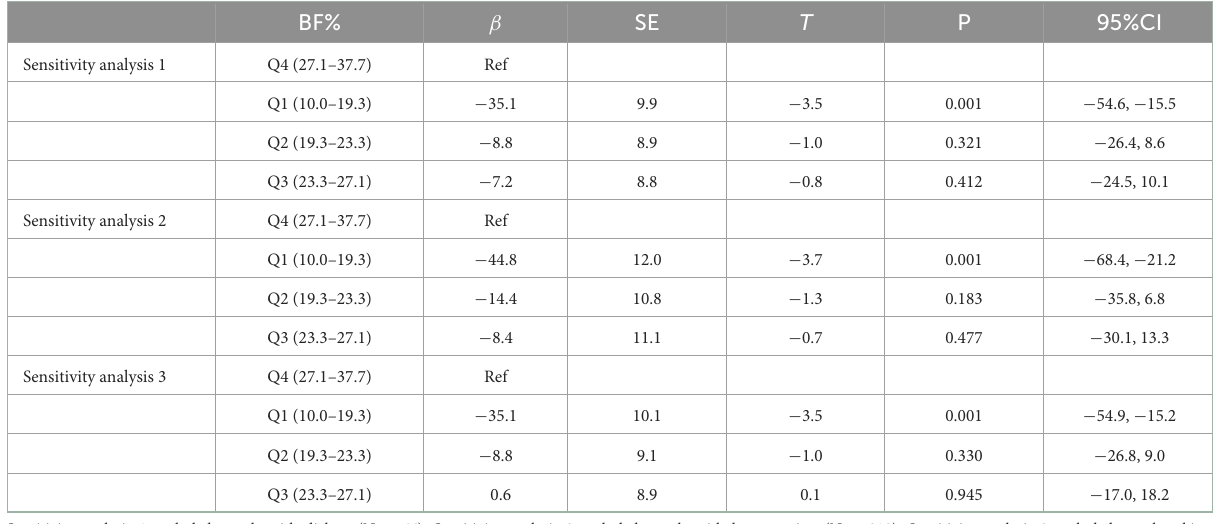
TABLE 4 Sensitivity analysis: Generalized linear analysis results of the between-group difference of 1 baPWV with BF%. BF% β SE T P 95%CI Sensitivity analysis 1 Q4